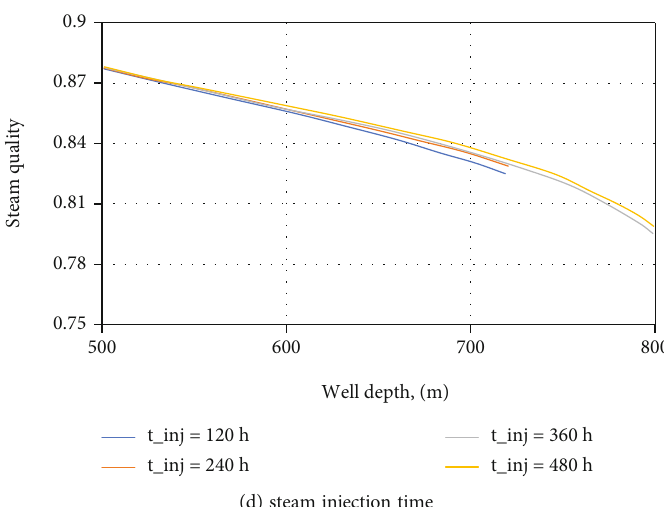
Figure 11: E ff ect of (a) steam injection rate, (b) steam quality at the heel, (c) pressure at the heel and (d) steam injection time on the distribution of steam quality along the